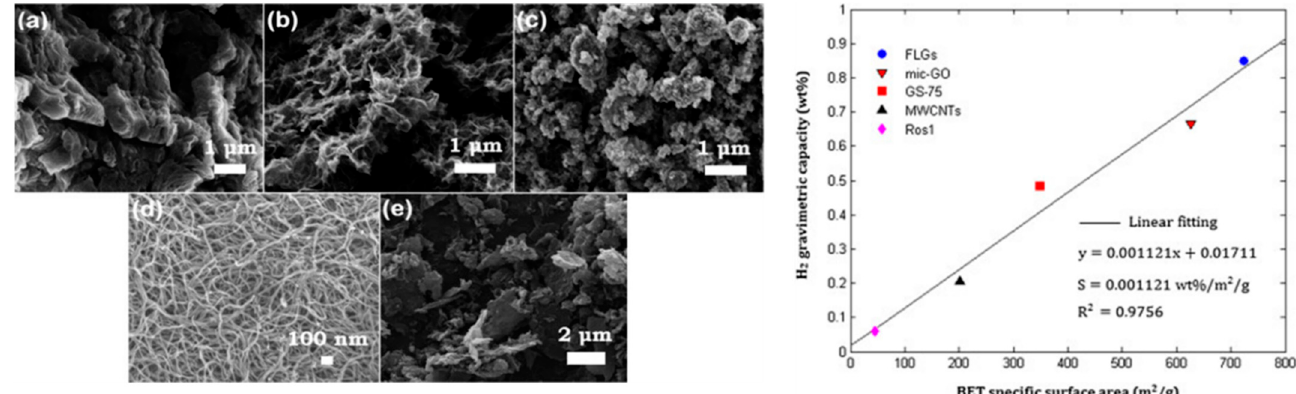
Figure 11. The comparison of nanoporous graphene oxide absorbents. On the left ( a ) exfoliated graphene oxide produced by microwave radiation (mic-GO), ( b ) sponge-like graphene hydrogel prepared by freeze-drying (GS-75)—; ( c ) Commercial few-layer graphenes in the form of nanoplatelets (FLGs); ( d ) commercial multi-walled carbon nanotubes (MWCNTs), and ( e ) commercial short multi-walled carbon nanotubes (Ros1). On the right—lot of correlation between hydrogen gravimetric capacity of these materials and BET specific surface area, measured at 77 K and 1 bar pressure [66]. Reproduced with permission from Kostoglou et al., International Journal of Hydrogen Energy, published by Elsevier, 2015.